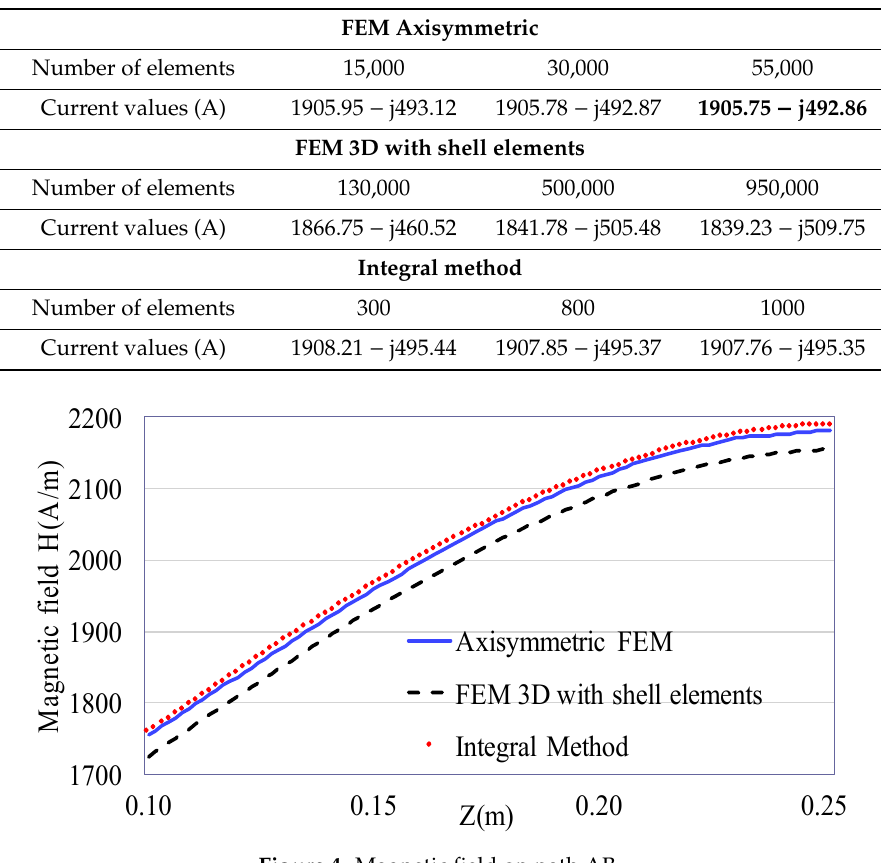
Figure 4. Magnetic field on path AB.